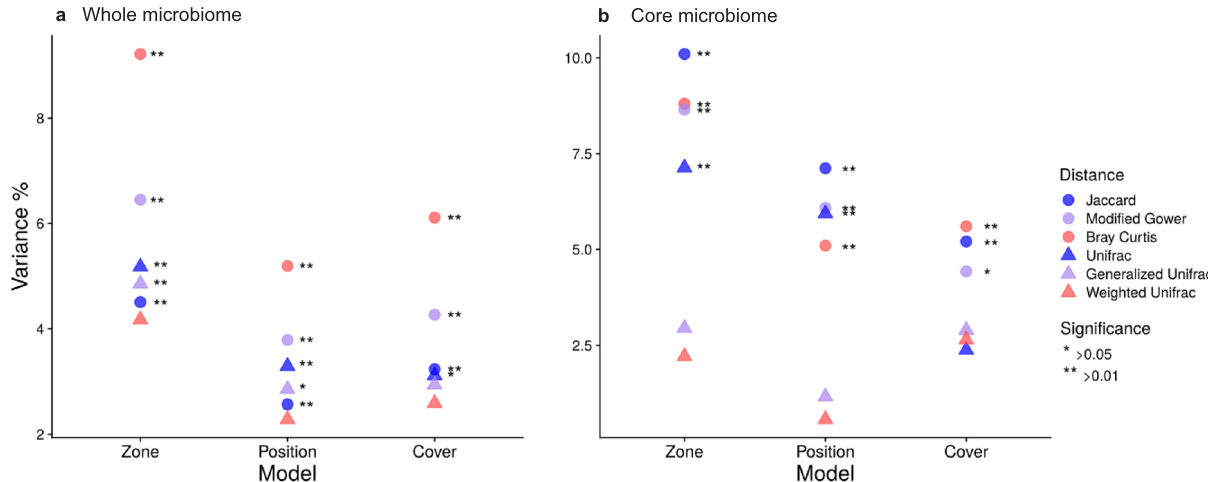
Fig. 5 PERMANOVA. Proportion of the variance explained in Permutational Analysis of Variance (PERMANOVA) comparing the composition of the whole gut microbiome ( a ) and the core gut microbiome ( b ) of Chaetodon capistratus . Three independent PERMANOVA analyses were conducted. The “ zone ” model compares gut microbiomes among the three zones of the bay (inner bay, inner bay disturbed, and outer bay). The “ position ” model contrasts the composition of gut microbiomes of fi sh collected at reefs inside and outside of the bay. The “ cover ” model compares gut microbiomes of fi sh on disturbed and undisturbed reefs inside of the bay. Three non-phylogenetic (circles) and three phylogenetic (triangles) dissimilarity metrics were used. They place more (red) or less (blue) weight on relative abundances.